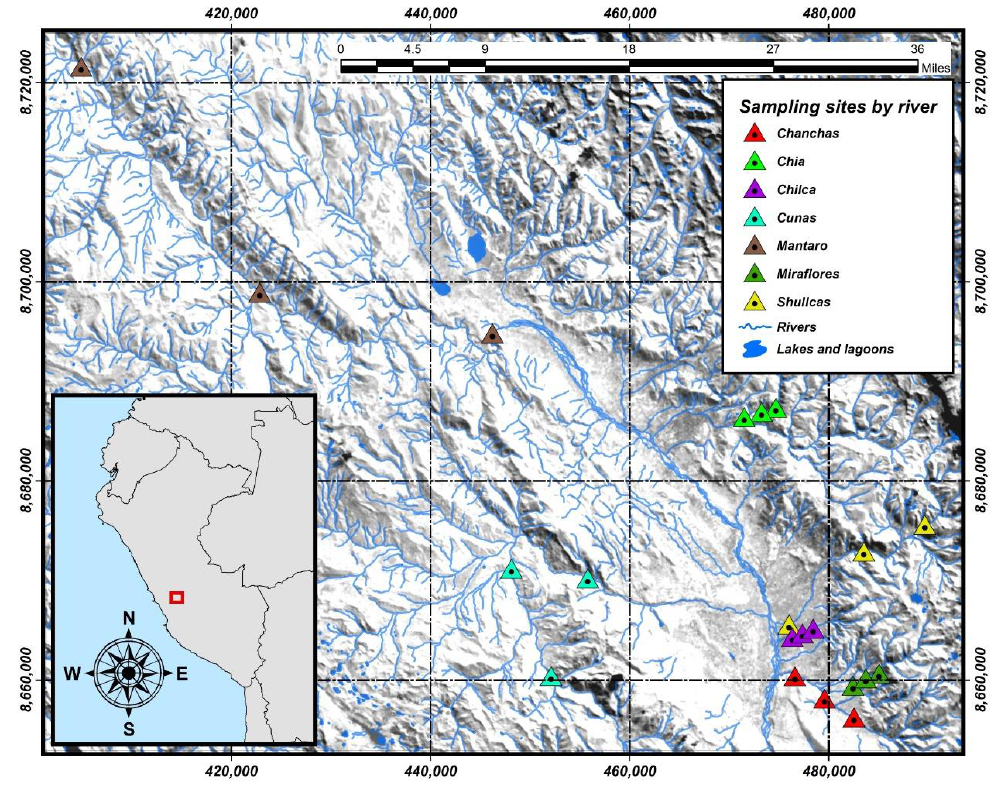
Figure 1. Location of the Mantaro river basin, tributary rivers, and sampling sites.